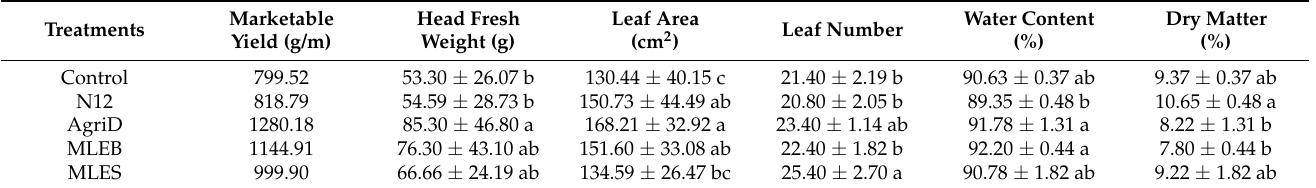
Table 3. Effect of biostimulant application on marketable yield and morphological parameters of